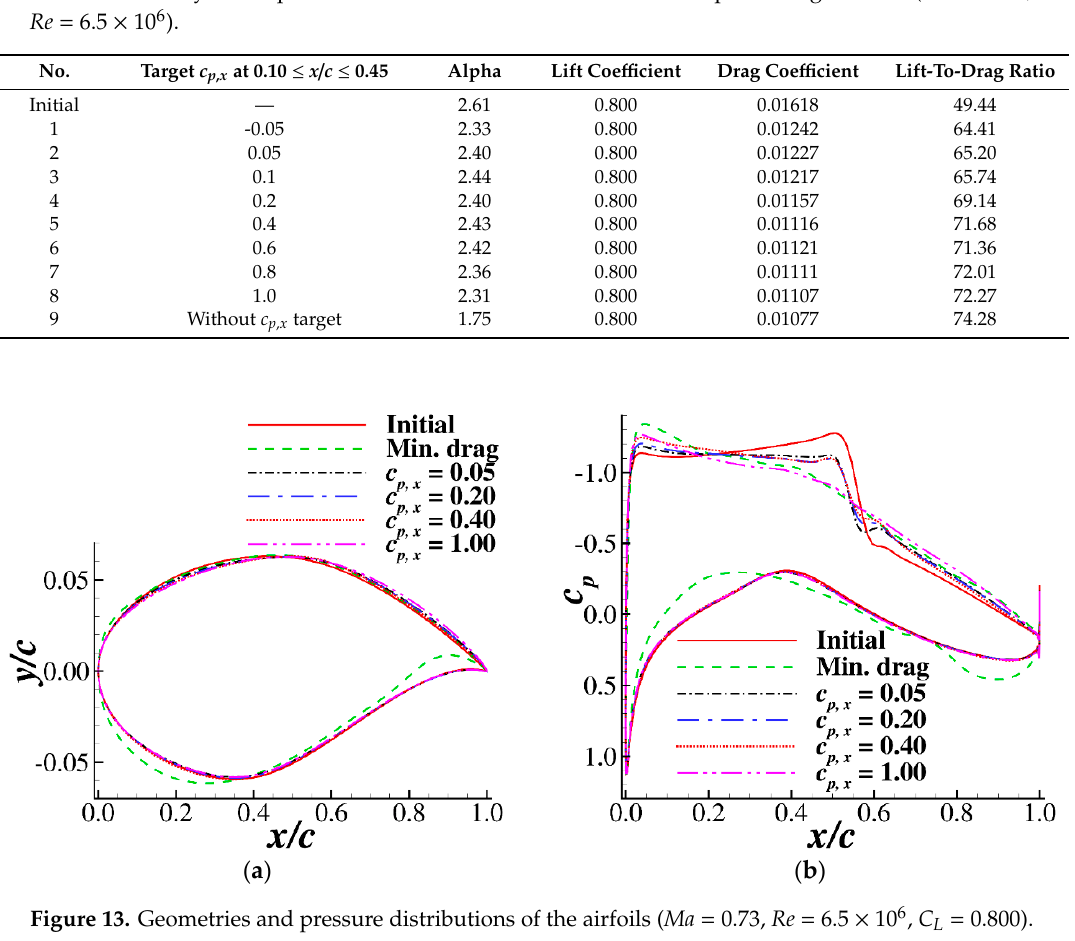
Figure 14. Pressure gradients on the upper surfaces of two airfoils ( Ma = 0.73, Re = 6.5 × 10 6 , C L = 0.800). 4.3. Drag Divergence Performance of Airfoils with Different Pressure Gradients The upper surface pressure gradient had a strong effect on the shockwave strength, which is important for the drag creep and drag divergence characteristics of a supercritical airfoil. The drag creep phenomenon is where the drag slowly increases from the subcritical Mach number to the supercritical Mach number, and the drag divergence is the fast increase after the design Mach number [36]. Poor drag creep performance may decrease the efficiency of the second-segment climb phase of an aircraft and increase the thrust requirement of the engine. In contrast, the drag divergence performance influences the cruise efficiency of a civil aircraft when cruising at a higher speed or altitude. Both good drag creep performance and drag divergence performance are demanded for aircraft design. Figure 15a shows the drag creep characteristics of the airfoils. The computations were carried out with the same lift coefficient C L = 0.800 and Reynolds number 6.5 × 10 6 . Under subcritical conditions, the drag coefficient slowly increased with increasing Mach number. The initial airfoil had the best drag creep performance, with the drag increasing the least from Ma = 0.45 to 0.65. In contrast, the minimum drag airfoil had the worst drag creep performance in that the drag increased dramatically. The second-segment climb phase of a civil aircraft is quite time consuming, especially for a short- or medium-range flight mission. Consequently, an airfoil optimized by minimizing the